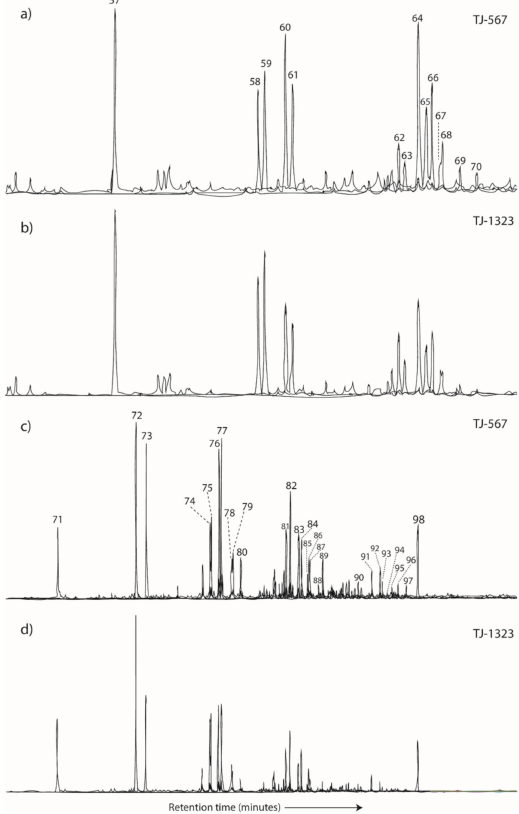
Figure 7. For TJ-567 and TJ-1323 oils, m / z 178 + 192 + 206 ( a , b ) and m / z 128 + 142 + 156 + 170 + 184 ( c , d ) ion chromatograms of the aromatic fraction. Phenanthrene and naphtalene series distributions are